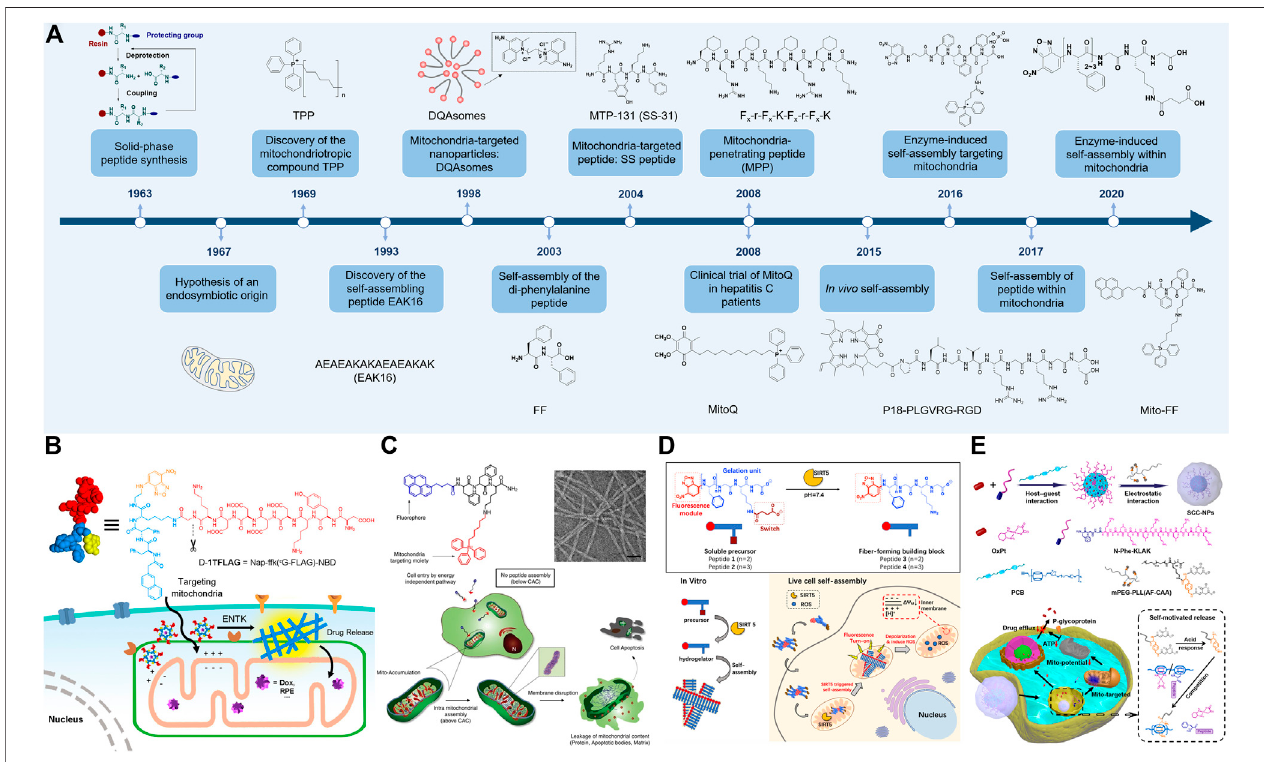
FIGURE1|(A) Abrieftimelineofselectedeventsformitochondria-targetedself-assemblyofpeptide-nanomaterials.Thereferencesareshownin Supplementary Table S1 . (B) In situ enzyme-instructed self-assembly of branched peptides around mitochondria. Reproduced with permission from ref (He et al., 2018). Copyright 2018 American Chemical Society. (C) In situ self-assembly of peptide amphiphiles in mitochondria due to the enhanced accumulation by targeting. Reproduced with permissionunderaCreativeCommonsCCBYLicensefromref(Jeenaetal.,2017).Copyright2017SpringerNature. (D) Insitu enzyme-instructedself-assemblyof peptides in mitochondria. Reproduced with permission from ref (Yang L. et al., 2020). Copyright 2020 American Chemical Society. (E) Self-motivated release of the mitochondria-cytotoxic peptide to strengthen the chemotherapy toward drug-resistant cancer cells. This fi gure has been published in CCS Chemistry 2021; Self- Motivated Supramolecular Combination Chemotherapy for Overcoming Drug Resistance Based on Acid-Activated Competition of Host – Guest Interactions is available online at 10.31635/ccschem.021.202100964;